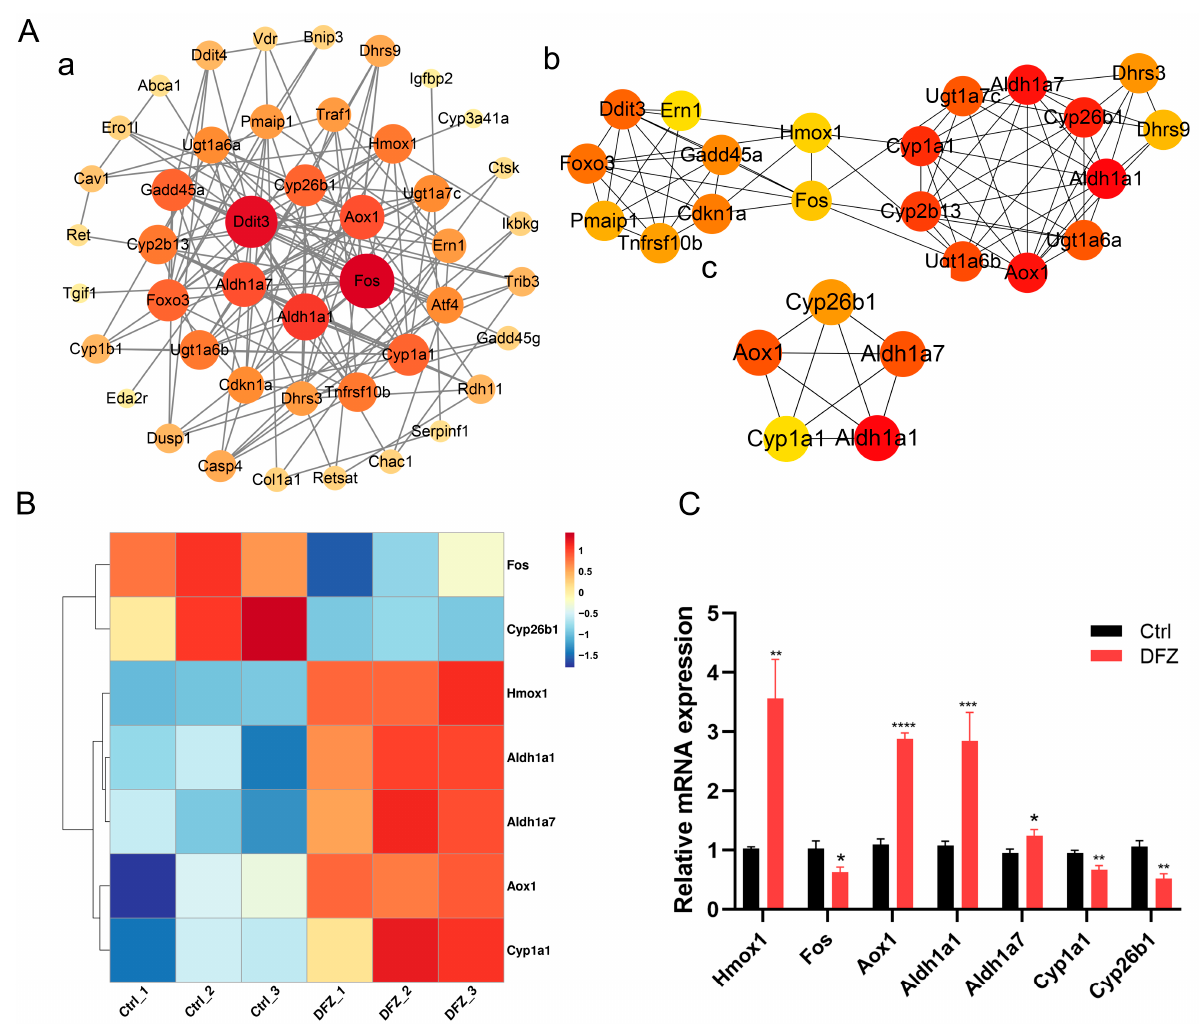
Figure 7. Screening and identification of key genes related to RA pathway and apoptosis. ( A ) (a,b) Protein–protein interaction (PPI) and (c) cytoHubba MCC analysis of DEGs enriched in RA pathway- and apoptosis-related terms. ( B ) Heatmap and ( C ) qPCR validation of identified key genes. * p < 0.05, ** p < 0.01, *** p < 0.001, **** p < 0.0001 versus the control group.